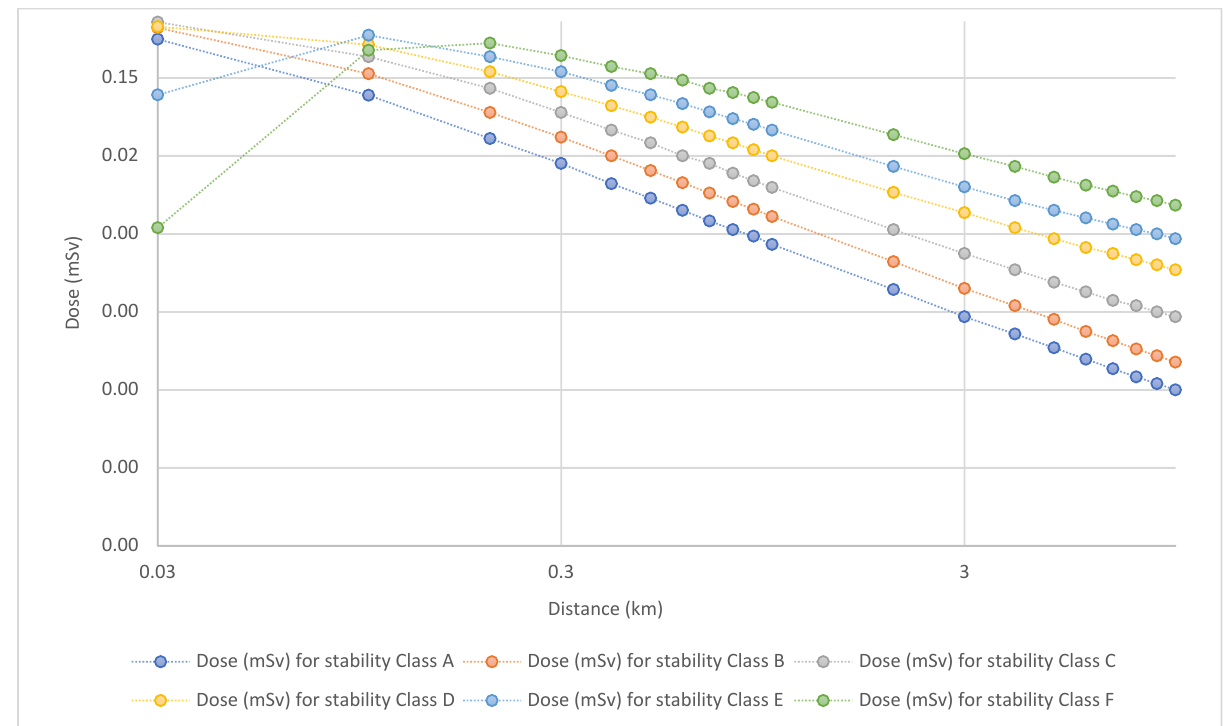
Figure 6. Dose from the HotSpot code for activity concentration below 1000 Bq/kg. As shown in Figure 7, the highest dose for stability class A at a distance of 0.03 km from the release point for ACs above 1000 Bq/kg was 4.3 mSv/y, which was above the ICRP-recommended public dose limit of 1 mSv/y. Just as shown in Figure 6, thin lines were used for clarity. The dose shown in Figure 8 was much higher than the dose shown in Figure 6 because of the high AC above 1000 Bq/kg. People are not advised to live within 10 km of the incinerator because it makes them prone to higher exposure doses.